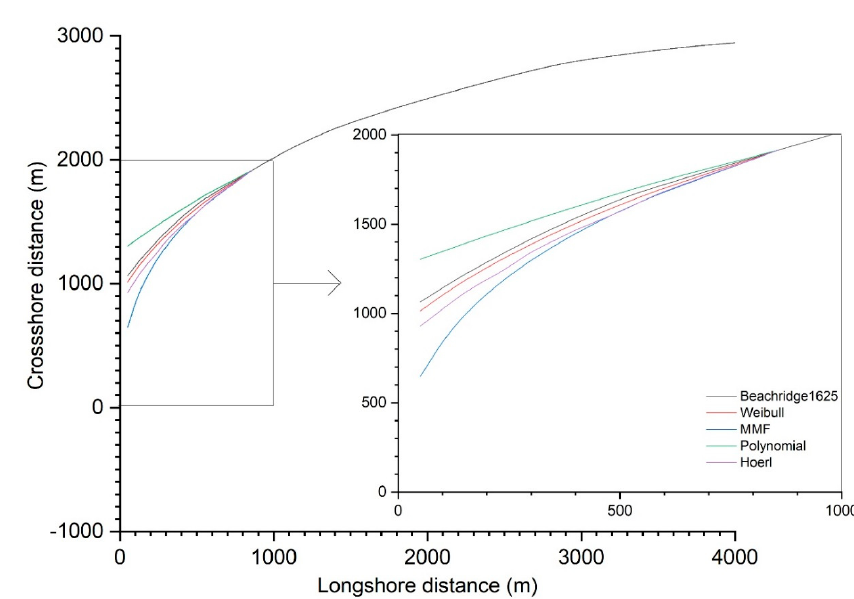
Figure 4. Real beach ridge 1625 ca., correlated to an erosional period, with the four best fitting mathematical functions.